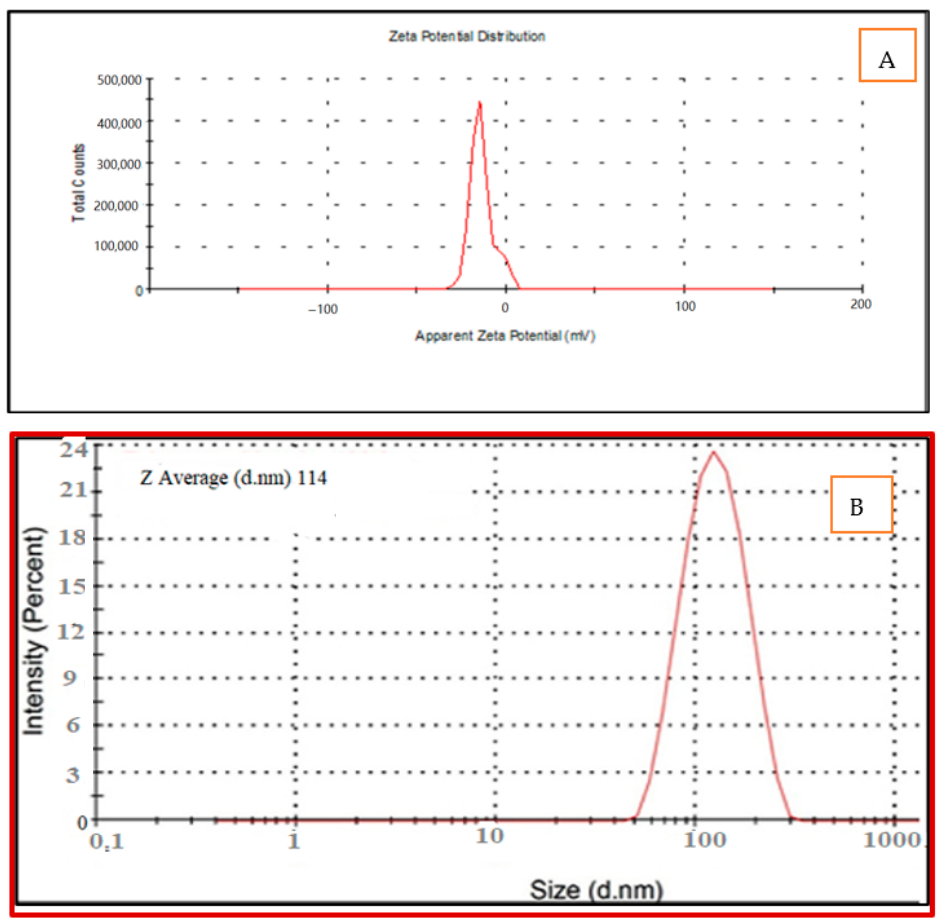
Figure 3. ( A ) Zeta potential analysis ( B ) Particle size distribution of Au-cellulose nanocomposite biosynthesized by Chlorella vulgaris.